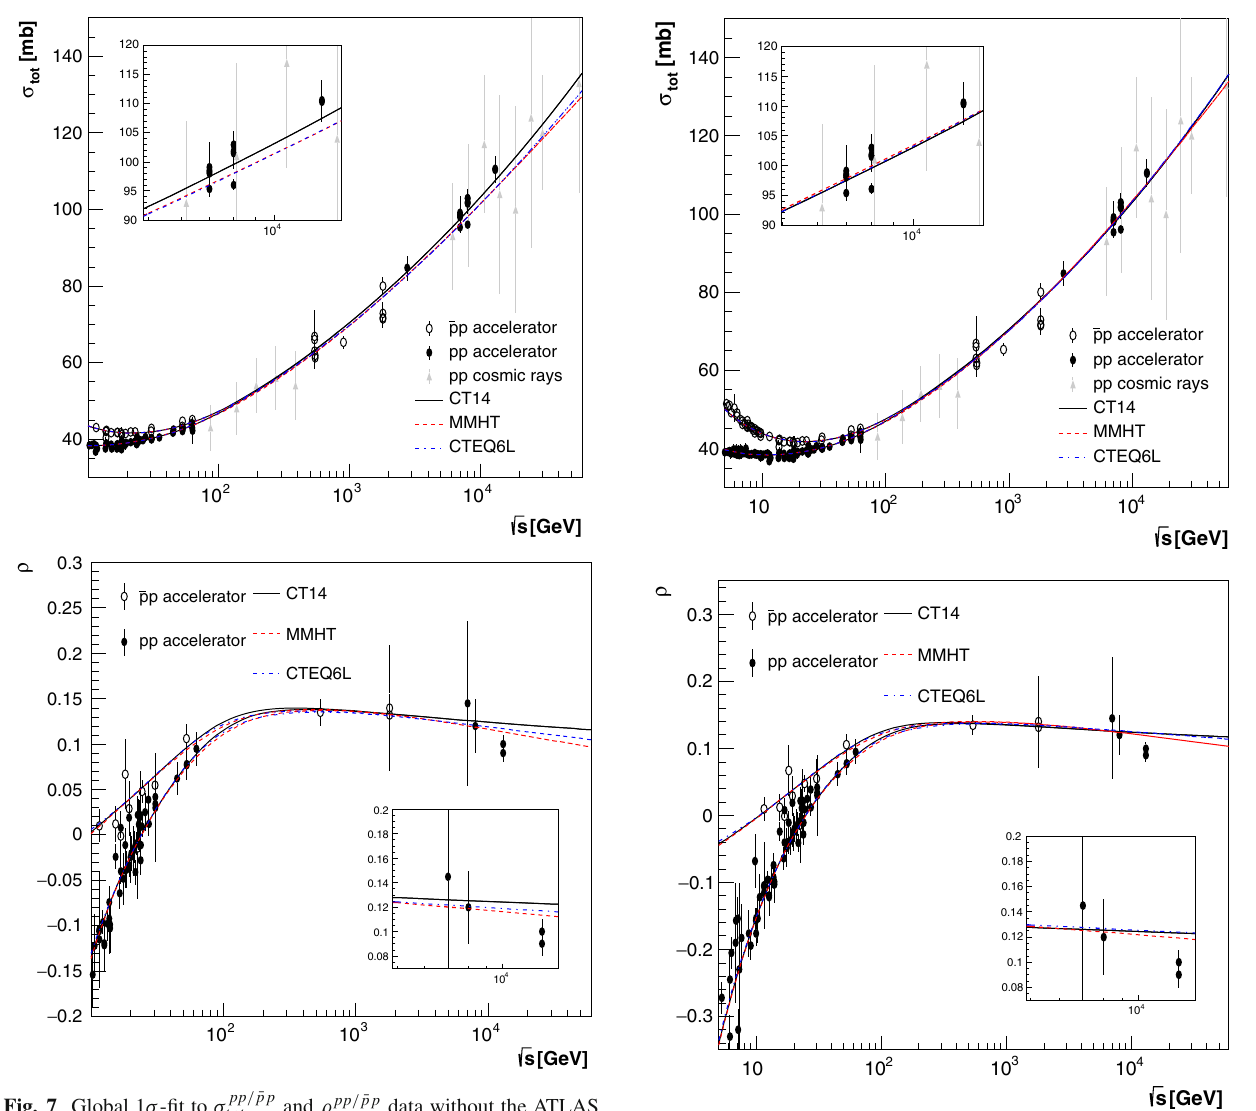
/ ¯ pp ρ pp / ¯ pp data without the ATLAS Fig. 8 Global 1 σ -fit to σ pp √ tot and s max = 13 TeV and low- measurements, for maximum-energy cutoff √ s min = 5 energy cutoff